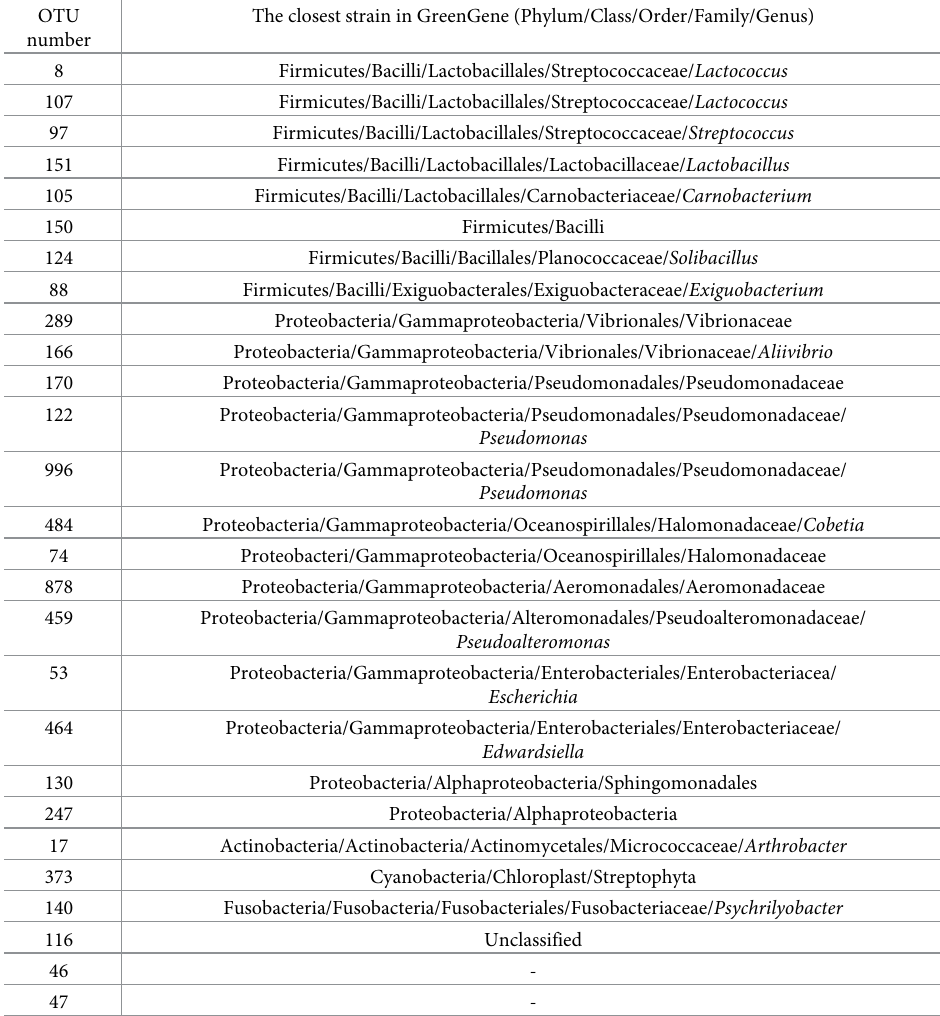
Table 1. Dominant operational taxonomic units (OTUs) in the intestinal tracts of turbot larvae. OTU The closest strain in GreenGene number